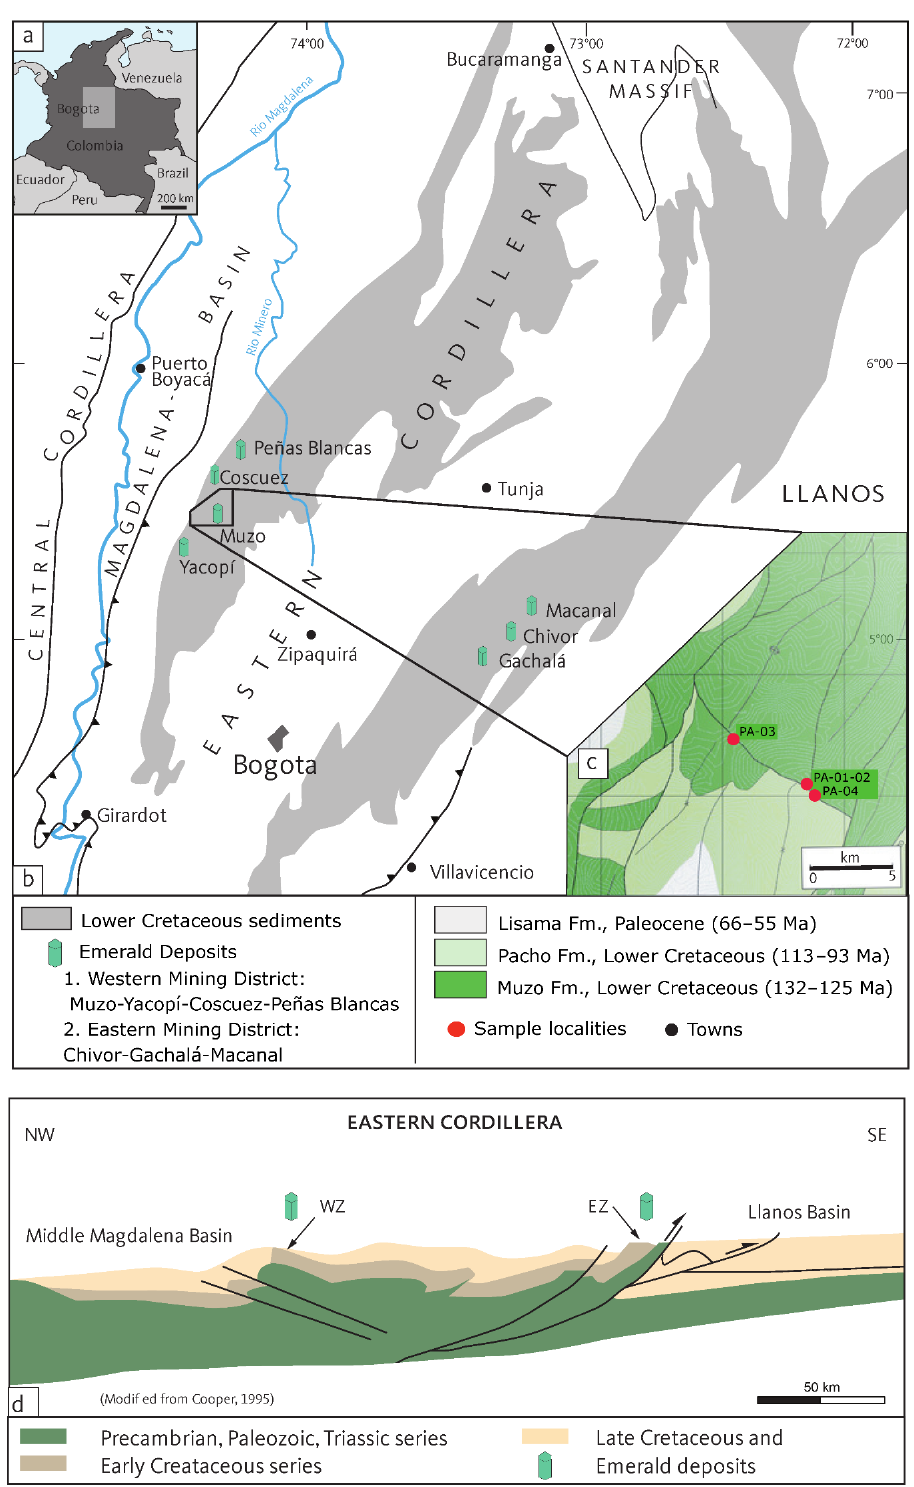
Figure 1. ( a , b ) Simplified map showing the major tectonic provinces of northwestern Colombia and its location in South America (inset a). ( c ) Detailed geological map of the sample area with sample localities. ( d ) Cross-section through the bivergent fold and thrust belt of the Eastern Cordillera. The over-thrusting of the two foreland basins containing the emerald deposits is shown: western zone (WZ, Muzo, Coscuez, Yacop í and Peñas Blancas) and eastern zone (EZ; Chivor, Gachal á and Macanal). ( a , b ) Modified after Branquet et al. (1999) and Cooper